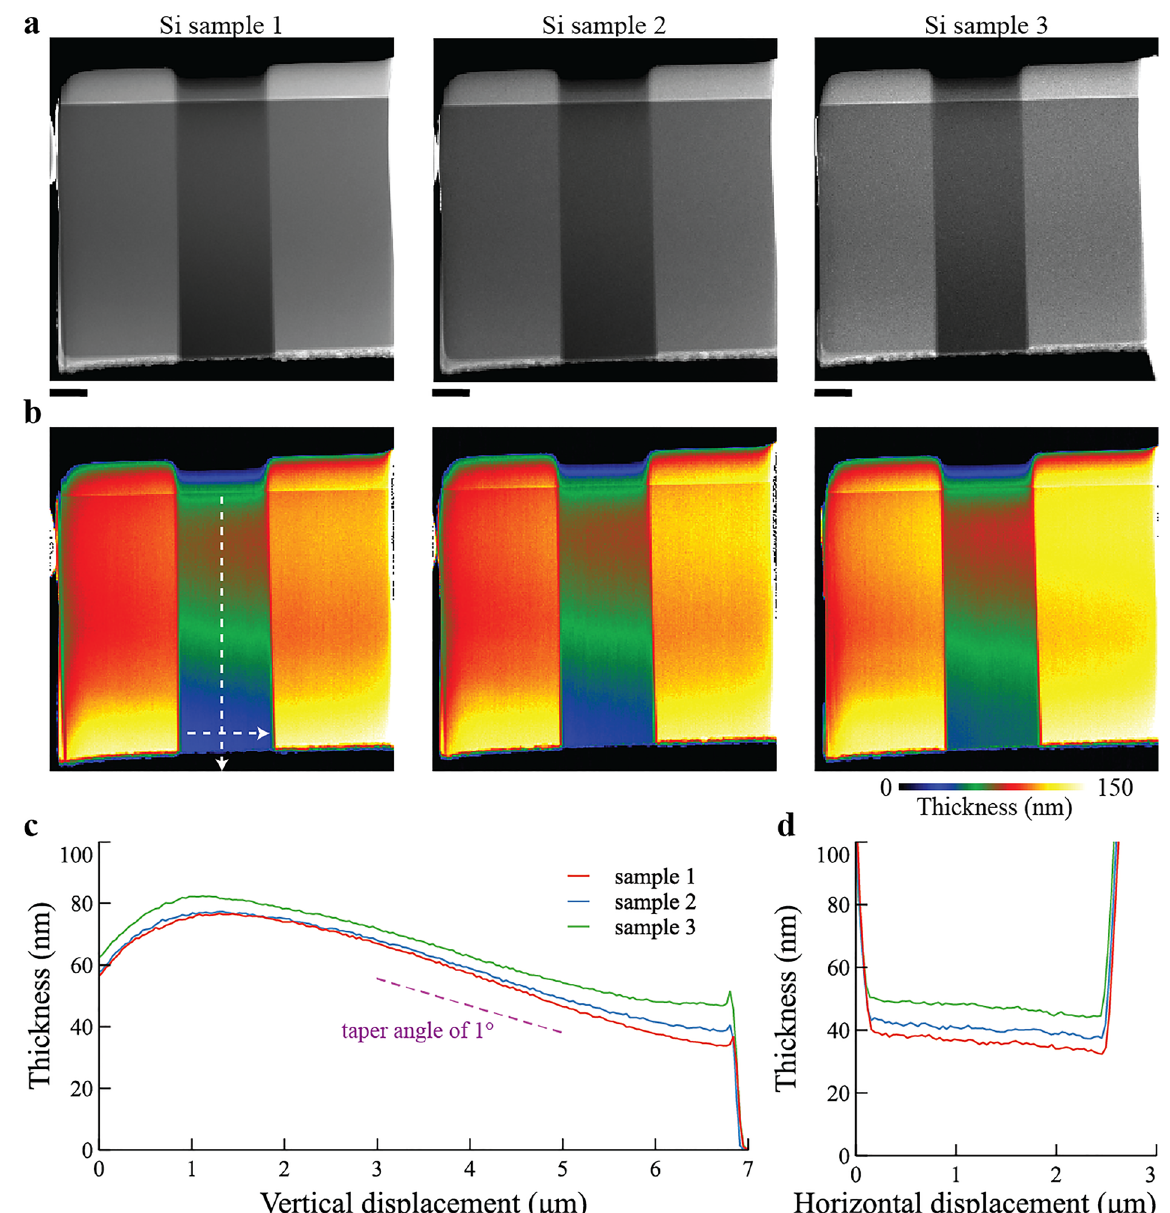
Figure 3. Sample shape and thickness repeatability of robotically prepared Si lamellae. ( a ) HAADF-STEM images of each sample. The three lamellae were fabricated using the Si-optimized settings. ( b ) Thickness maps generated from EELS spectrum imaging. ( c ) Thickness profiles in the vertical direction (from the top protective layer to the bottom edge). The dashed line shows a 1.0° taper angle. ( d ) Thickness profiles horizontally across the thin window near the bottom edge. The scale bar is 1